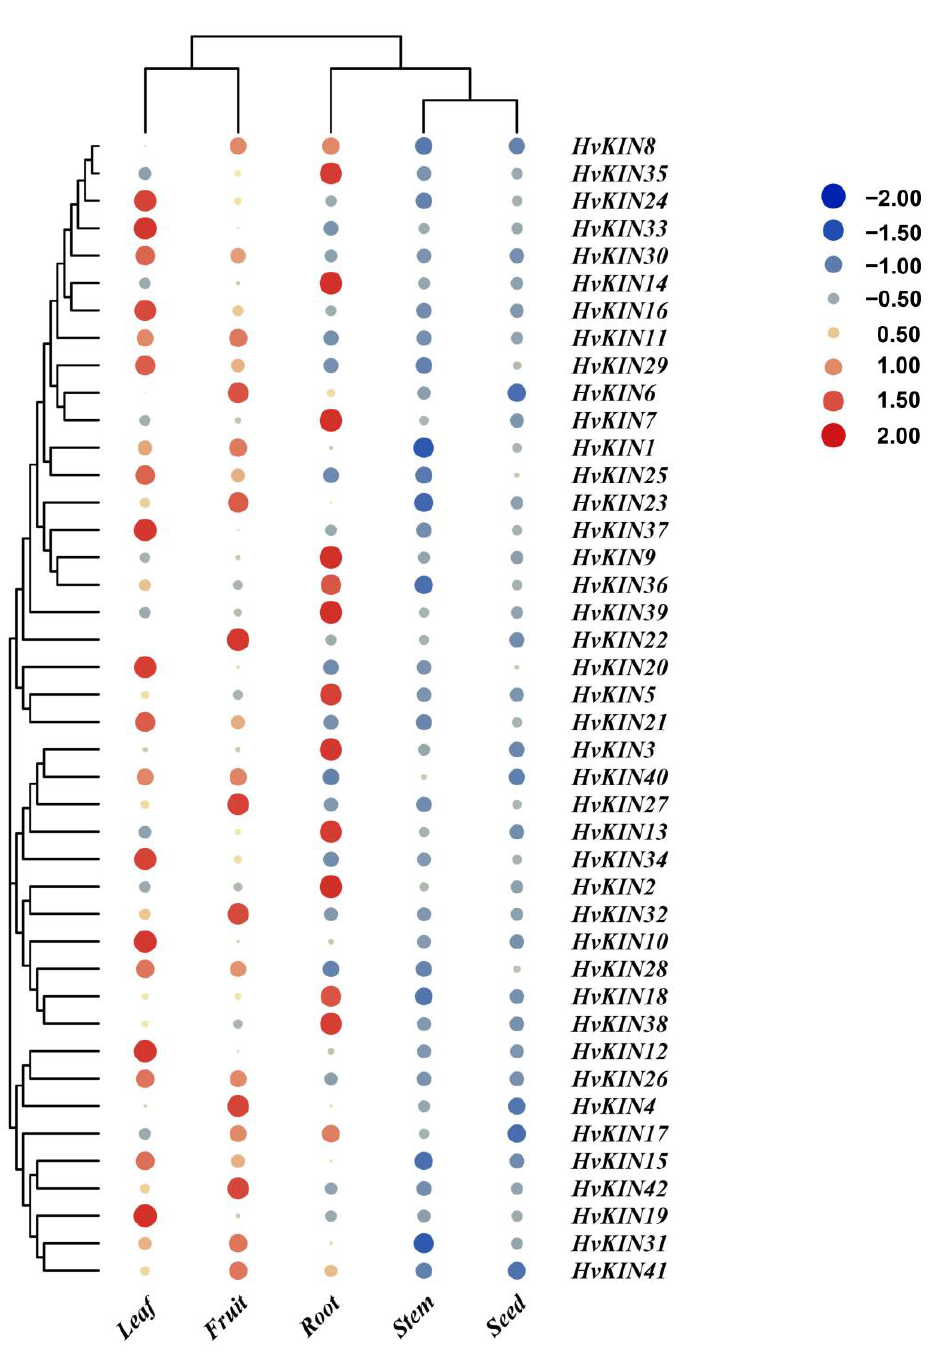
Figure 9. QRT-PCR analysis of the expression level of the HvKIN s in different organs of barley. The data summarized at least three biological replicates.